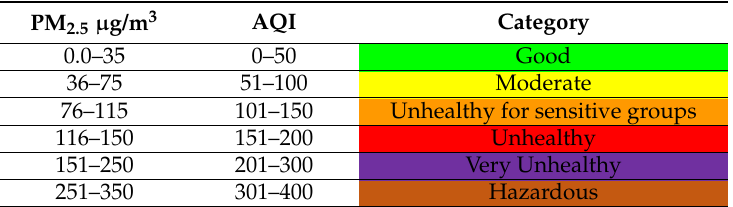
Table 2. AQI levels and category for calculating PM 2.5 subindex adapted from the Ministry of Environmental Protection (MEP 2012). Each color conforms to a given category.